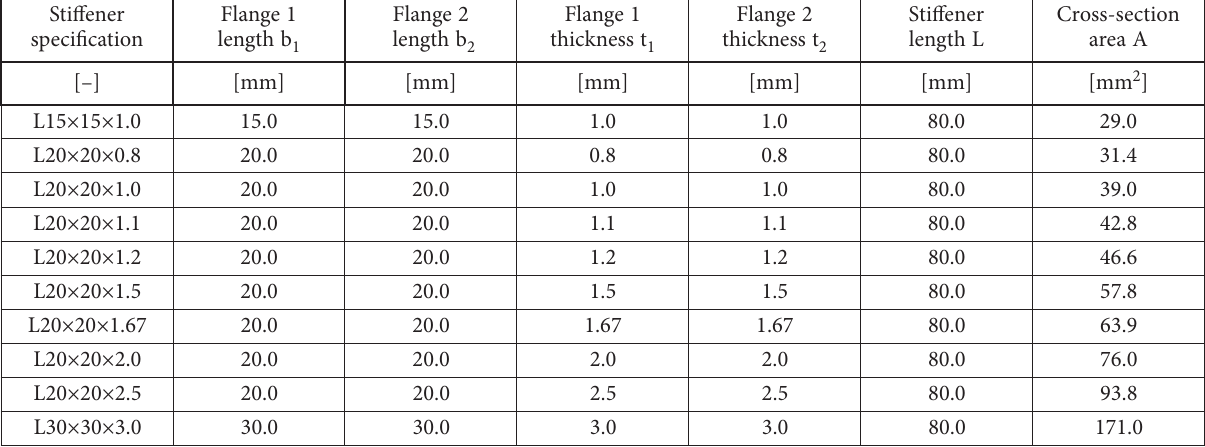
Table 1. Specification of stiffener geometry